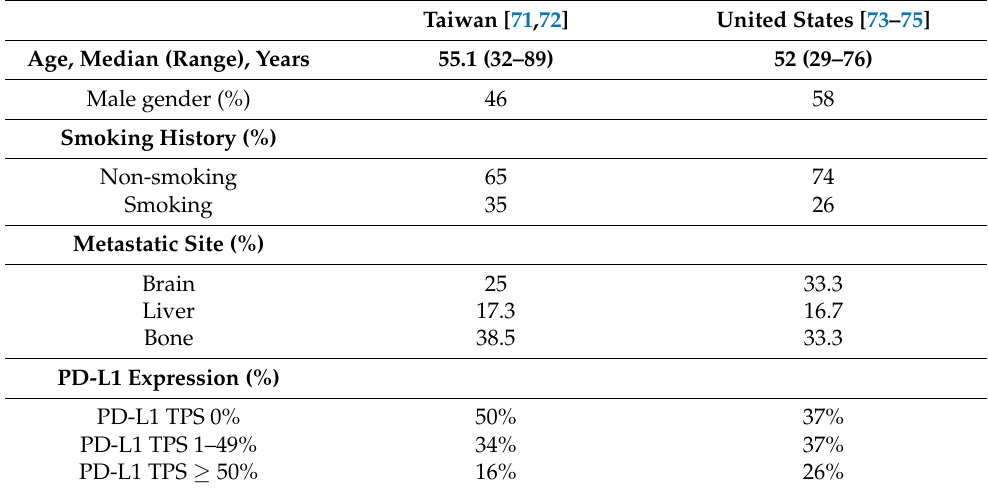
Table 2. Characteristics of ALK-positive NSCLC in Taiwan compared with those in the United